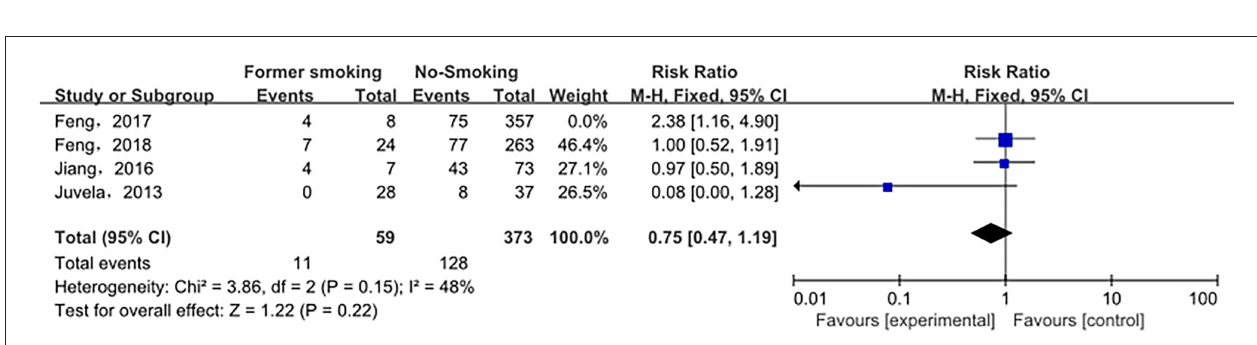
former smoking group and the non-smoking group